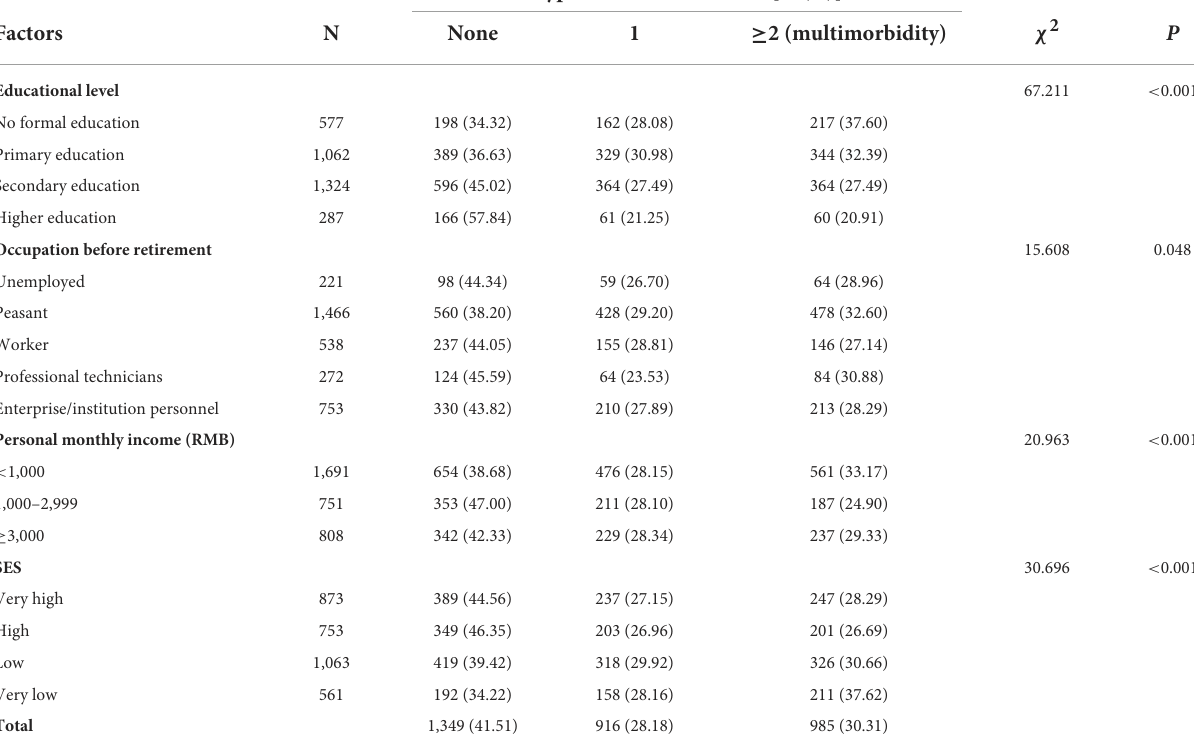
TABLE 2 Multimorbidity with SES in older